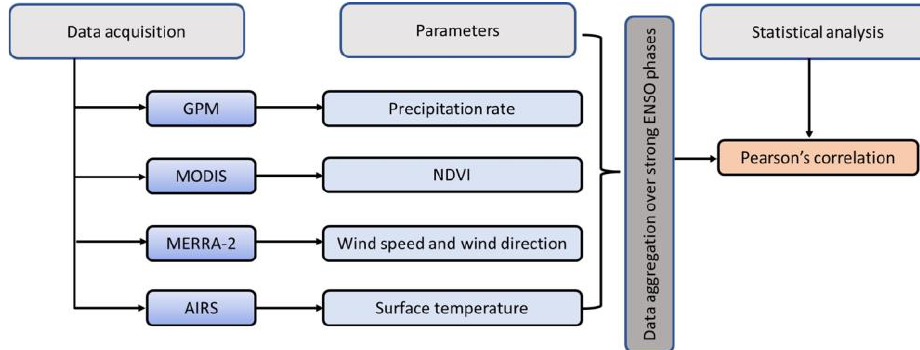
Figure 2. Flowchart summarizing the data and methods used in this study.